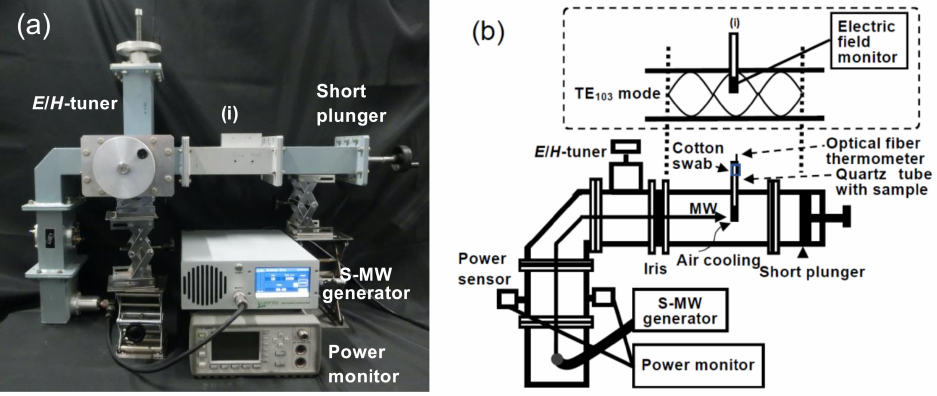
Figure 7. Photograph ( a ) and schematic ( b ) of the microwave irradiation system consisting of a 2.45 GHz S-MW generator (semiconductor microwave generator), an optical fiber thermometer, a power sensor, a power monitor, and a single-mode applicator. Inset in ( b ): distribution of the (i) electric field inside the single-mode applicator and location of the sample. E , electric field; H , magnetic field; TE, transverse